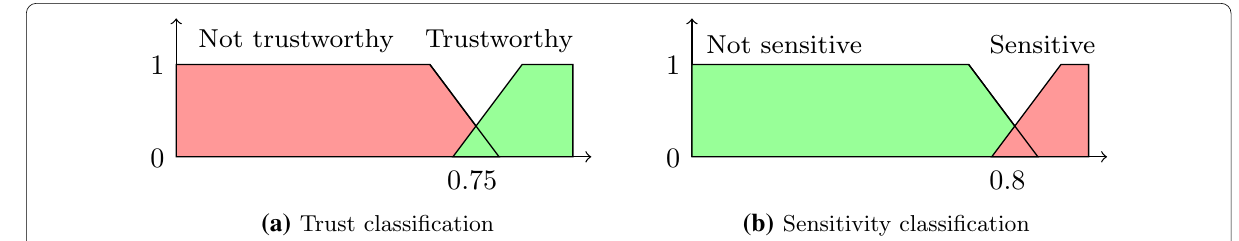
Fig. 2 Fuzzy view of considering user trustworthiness and object